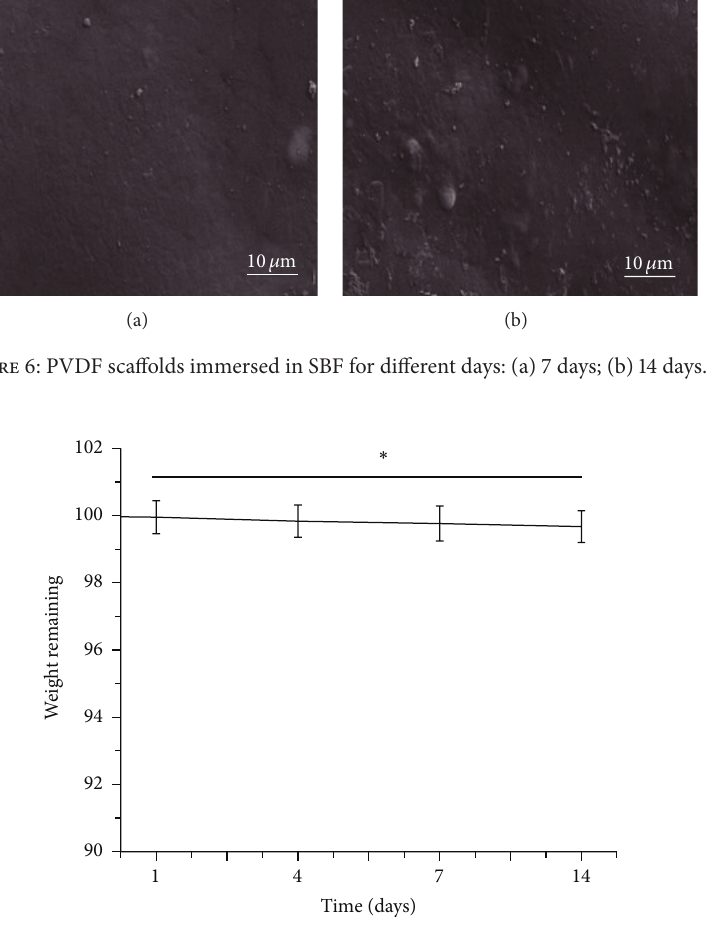
Figure 7: The remaining weight percentage of PVDF scaffolds after immersing in SBF for different days ( ∗ 𝑃 < 0.05